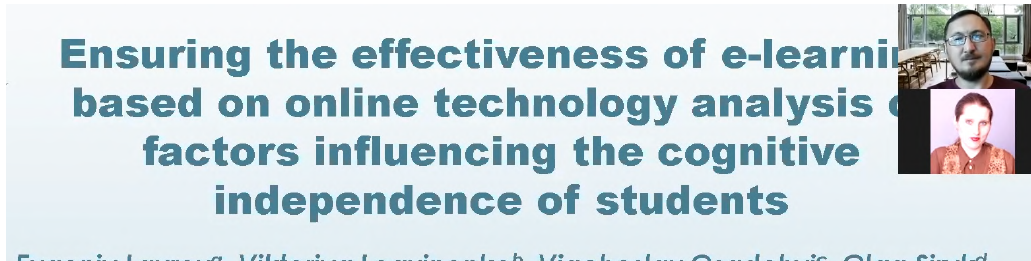
Figure 66: Presentation of paper